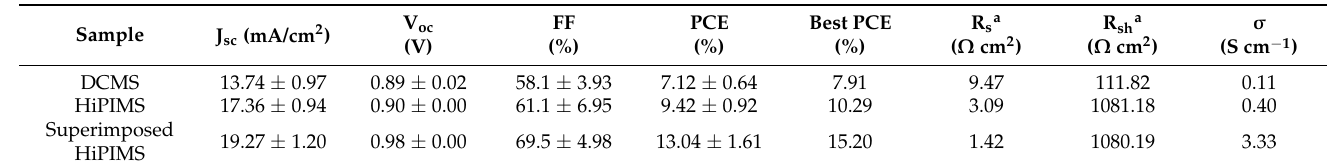
Table 1. Di ff erent process technologies for solar cell devices. Table 1. Different process technologies for solar cell devices.